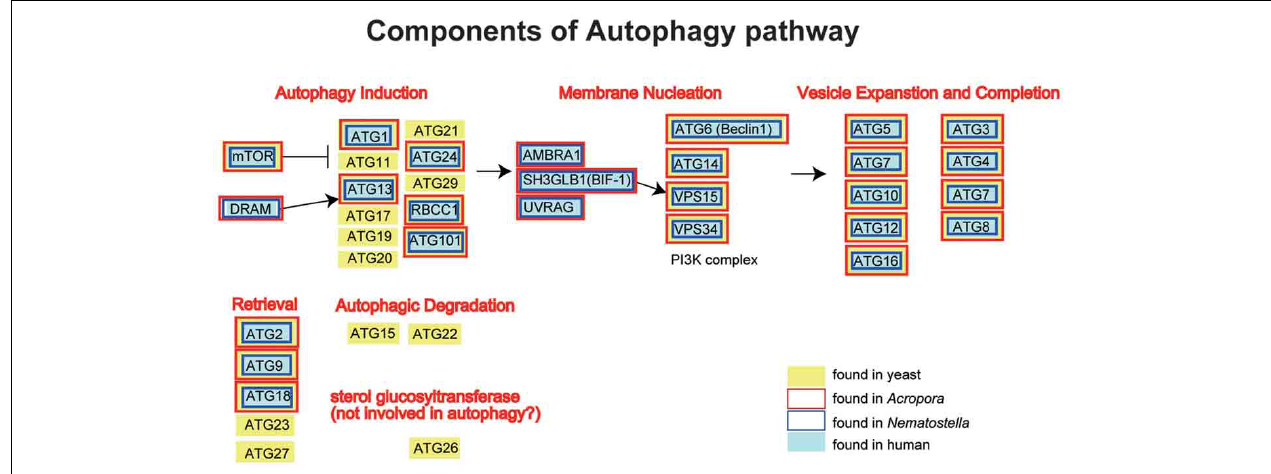
FIGURE 5 | Schematic presentation of the autophagy pathway, and human (gray backgroud) and yeast genes ( Saccharomyces cerevisiae ; yellow background) involved in the pathway. The pathway is composed of autophagy induction, membrane nucleation, vesicle expansion and completion, retrieval and autophagic degradation. Genes found in the